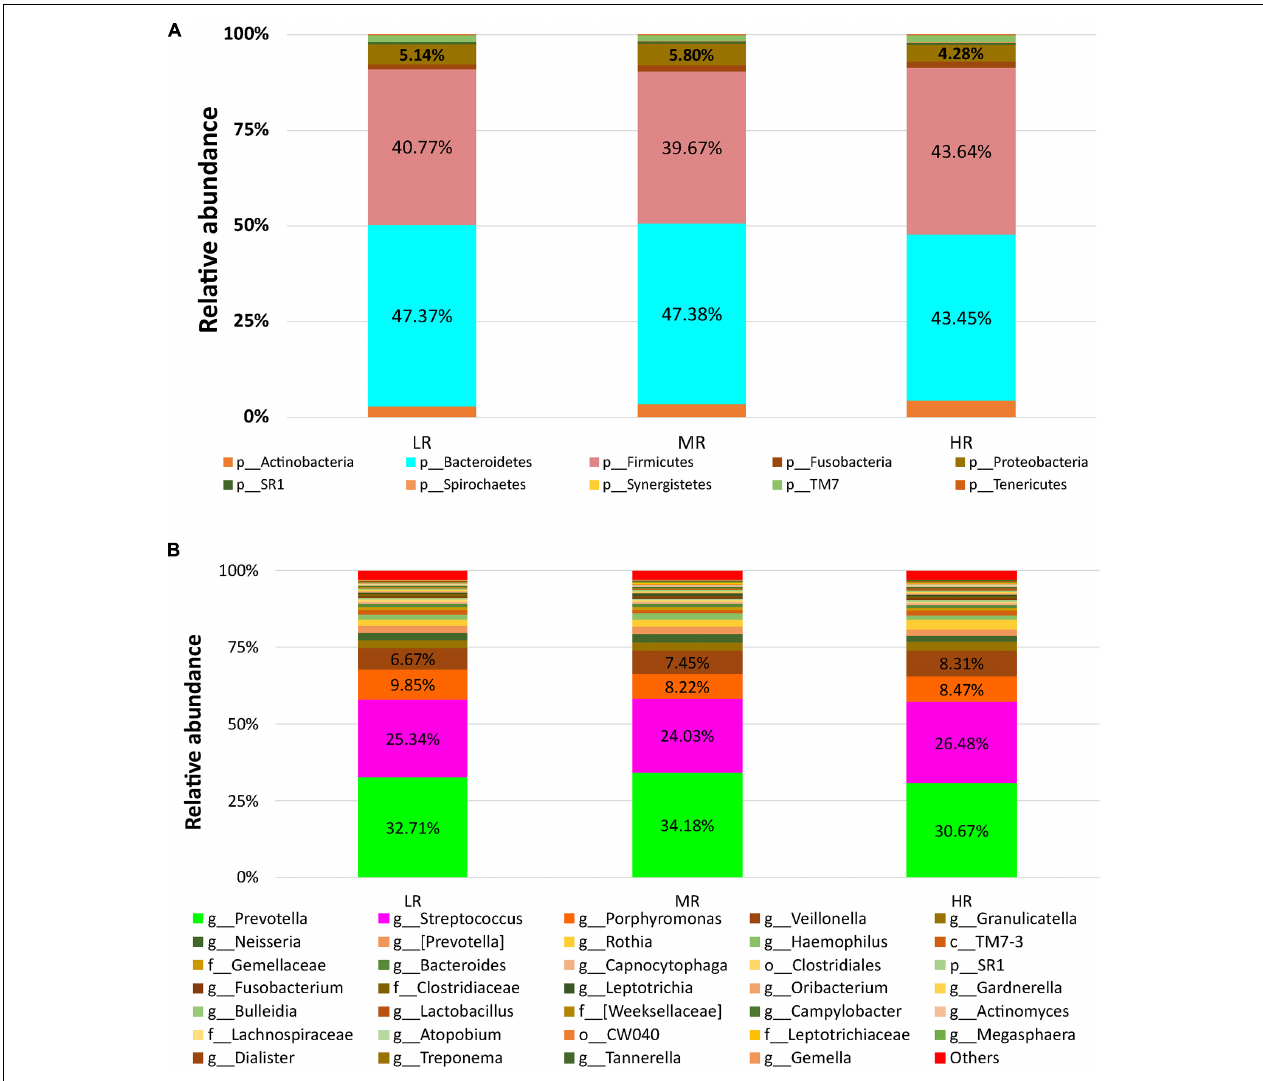
FIGURE 2 | The salivary microbiome composition of CVD risk groups. Y -axis shows % of relative abundance of the microbiome; X -axis indicates the microbial abundance in LR, MR, and HR groups; (A) phylum level; (B) genus level.